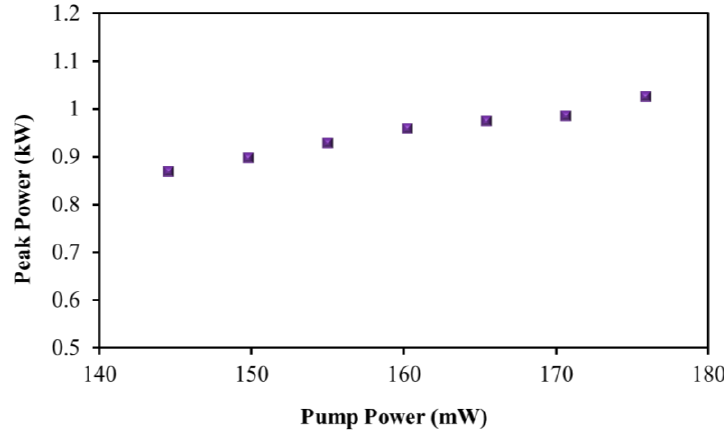
Figure 11. Peak power of mode-locked pulse.